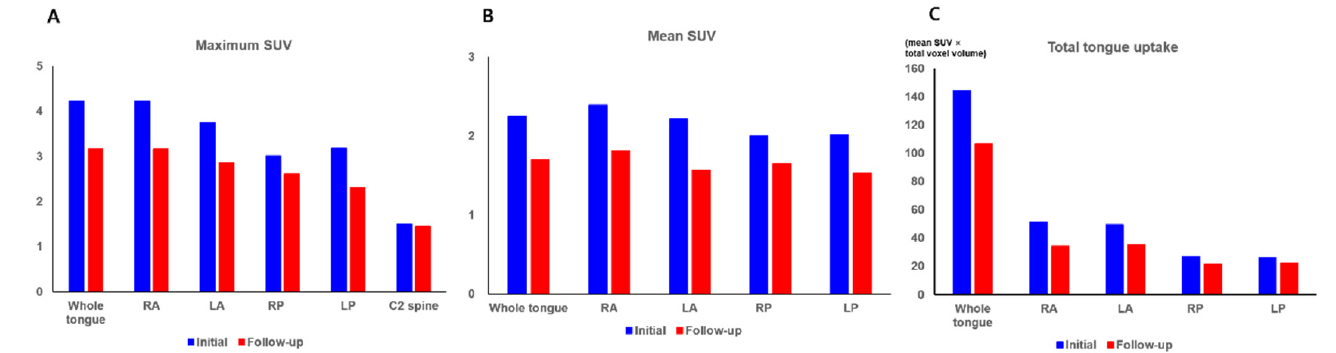
instructed to continue the medications as indicated.